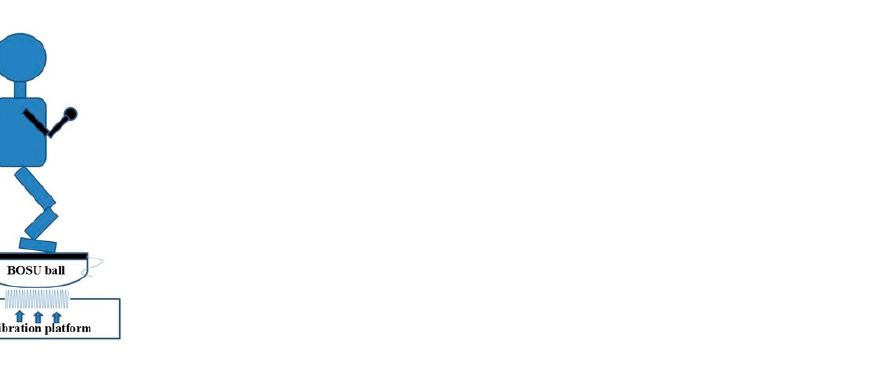
Table 1. Variables calculated from the aiming point trajectory.